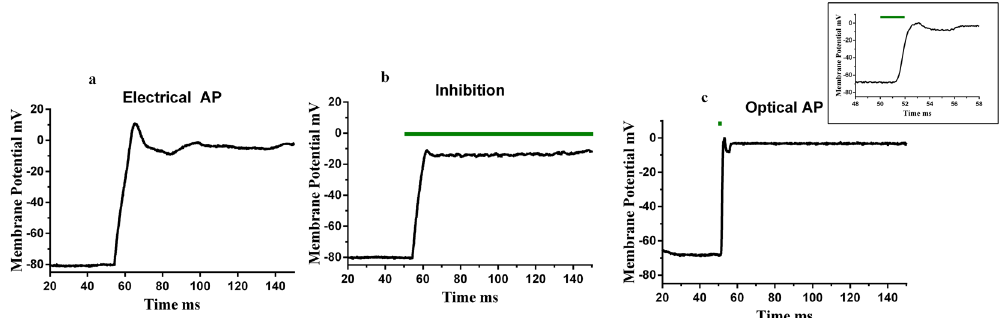
Figure 7. Optical inhibitory and excitatory response – Whole Cell Current Clamp Recording. ( a ) Action potential of a representative SH-SY5Y cell in response to 180 pA, 300 ms electrical pulse. Subsequently, inhibition (120 mW, 532 nm green laser pulse was superimposed on 180 pA electric current pulse) and activation (2ms, 120 mW laser pulse) in response to laser stimulation were recorded. Part b and c shows the inhibition and activation recordings respectively, inset of part c shows the long time scales of the optical action